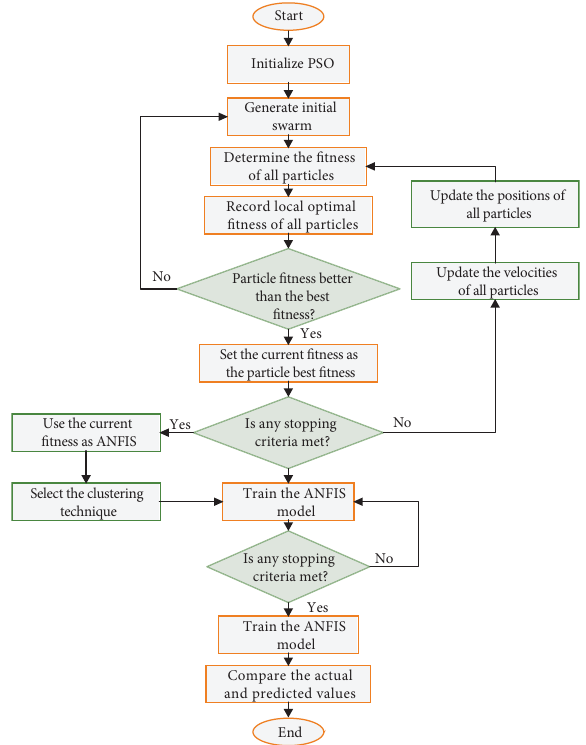
Figure 4: MPSO-ANFIS fowchart.